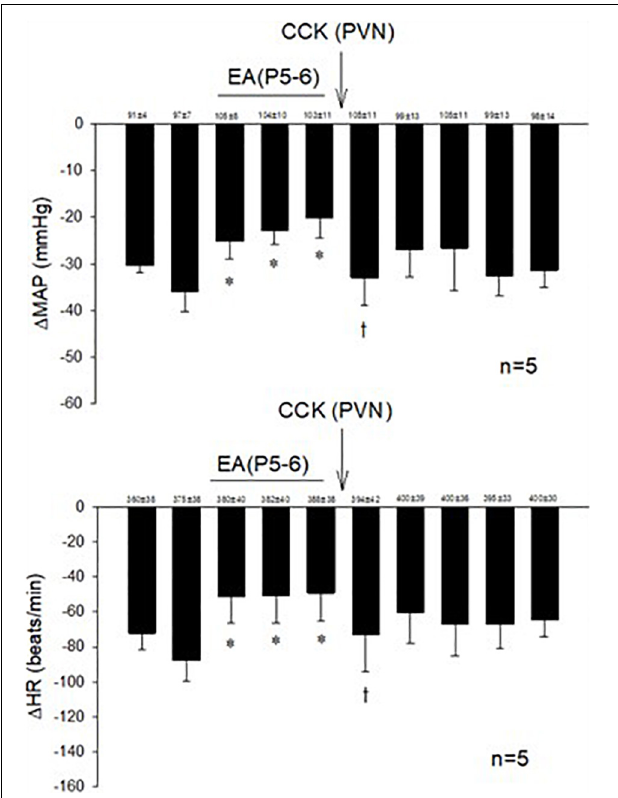
FIGURE 4 | Rats non-responsive to EA at the P5-P6 acupoint (overlying the median nerve) were tested with second EA treatment to modulate the PBG-induced Bezold-Jarisch reflex responses. Vehicle control and saline control do not affect the lack of responsiveness to EA in the